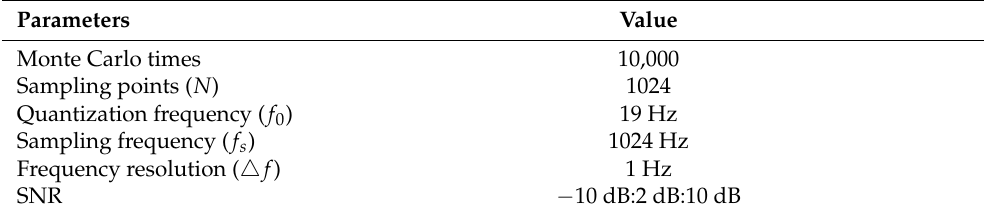
Table 1. Simulation